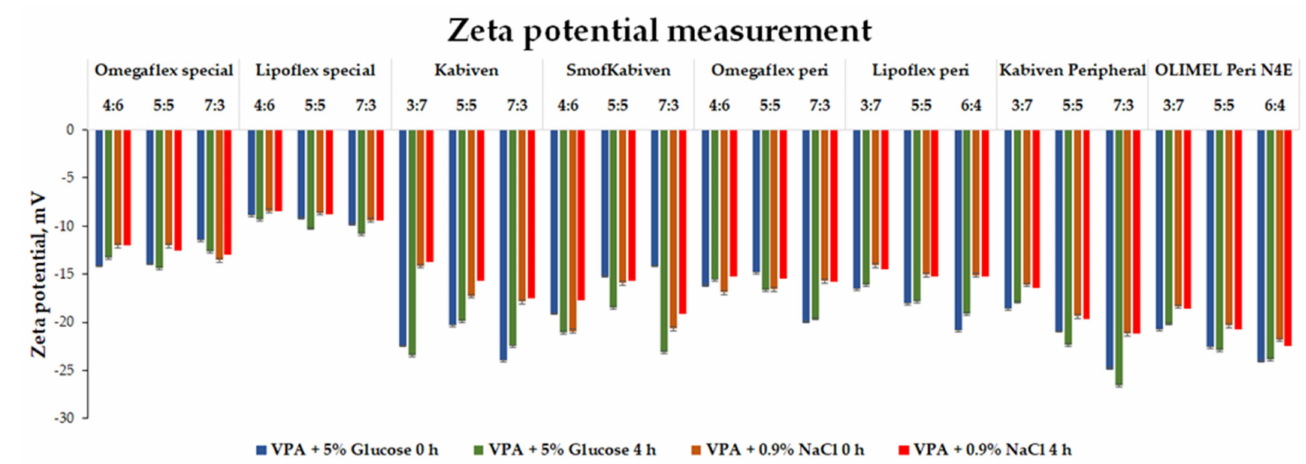
Figure 1. Results for pH, osmolality, and zeta potential measurements for mixed PNA with drug solutions (VPA + 5% Glucose or 0.9% NaCl).